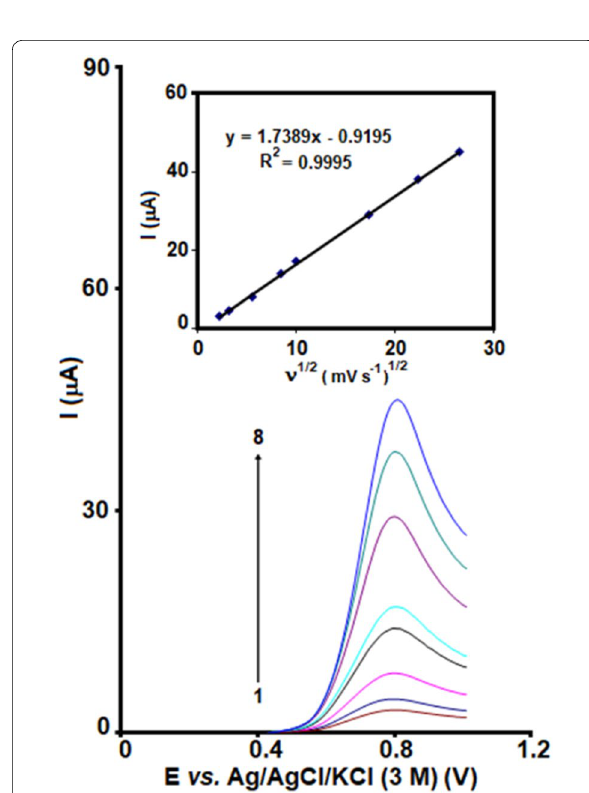
Fig. 2 LSVs of MCSNP/SPE in 0.1 M PBS (pH 7.0) containing 20.0 µM ACh at various scan rates; numbers 1–8 correspond to 5, 10, 30, 70, 100, 300, 500 and 700 mV s − 1 , respectively. Inset: Variation of anodic peak current vs. square root of scan